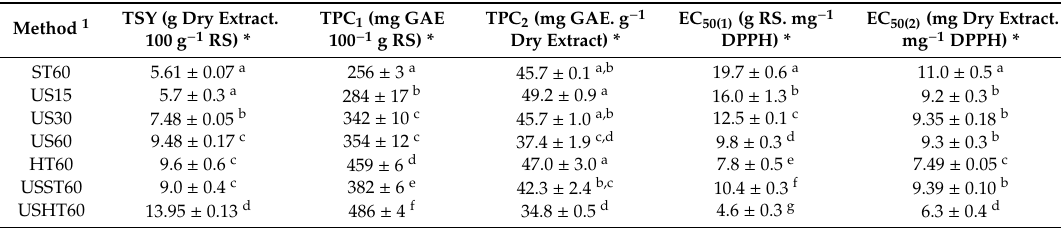
Table 2. Total solid yield (TSY), total phenolic content (TPC) and antioxidant capacity (EC 50 ) of the di ff erent extracts. Phenolic content and antioxidant capacity were expressed per mass unit of RS and dry